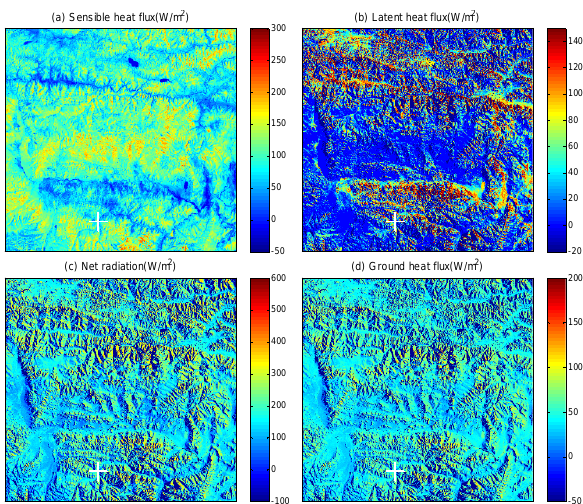
Fig. 5. Distribution of each surface energy balance item over the study area of Fig. 1b at 10:30LT on 9 April 2010, the cross line is the location of the station. The geographical information is the same as bottom-left picture of Fig. 1.